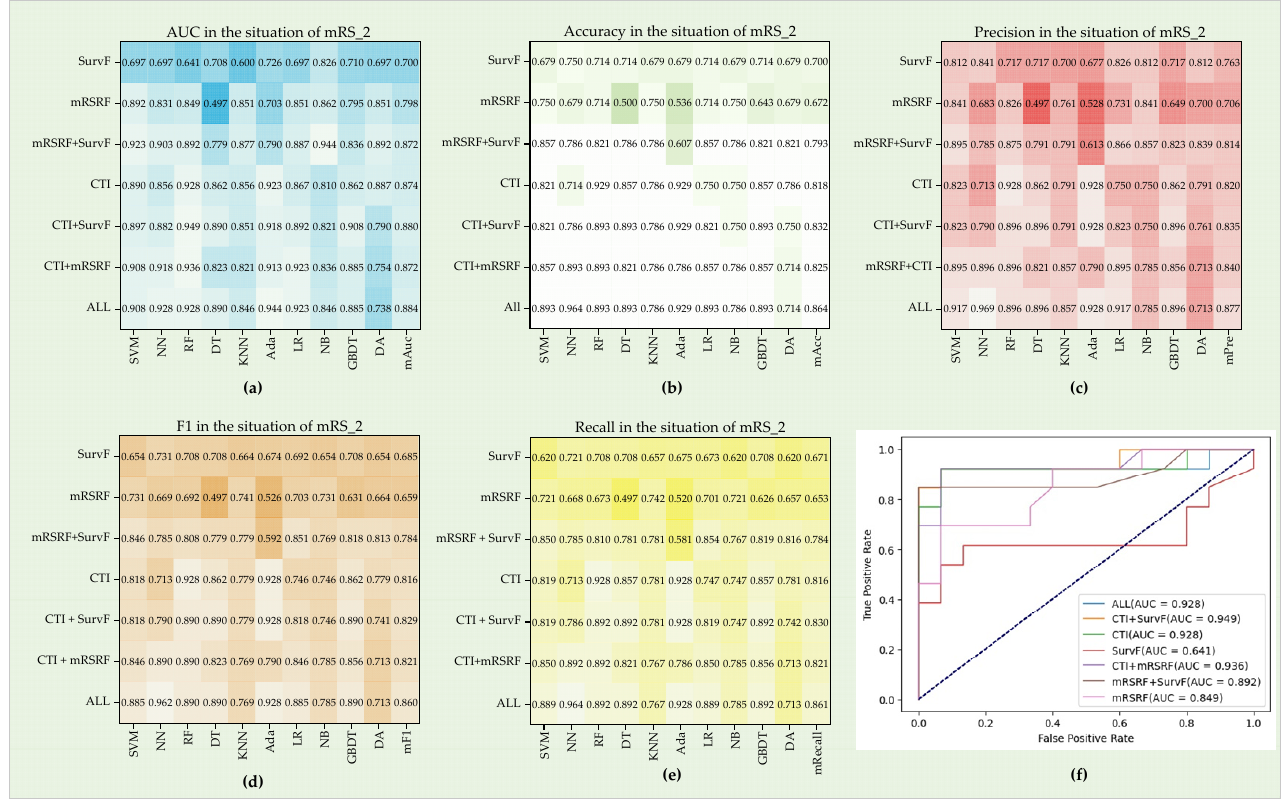
Figure 7. Performance of seven feature groups in the situation of mRS_2. ( a – e ) Auc, Pre, Acc, F1, and Recall on the ten models. ( f ) ROC curves of seven feature groups on the RF model. For mRS_4 (seen in Figure 8), the best Auc, Pre, Acc, F1, and Recall are 0.908, 0.858, 0.821, 0.802 and 0.815, respectively. ALL achieves the best mAuc of 0.787, while CTI + SurvF performs best with mAcc = 0.611, mPre = 0.622, mF1 = 0.595, and mRecall = 0.611. The results that SurvF will improve the outcome prediction and clinical performance better than mRSRF are similar to their performance in mRs_2. Moreover, the combination of CTI + mRSRF performs better than CTI in models LR, NB, and DA. For mRS_7 (seen in Figure 9), the best Auc, Pre, Acc, F1, and Recall are 0.902, 0.821, 0.75, 0.739, and 0.739, respectively. From the mean of the five indexes, CTI + SurvF performs best with mAuc of 0.788, mPre of 0.519, mAcc of 0.529, mF1 of 0.495, and mRecall of 0.47, followed by CTI, ALL, CTI + mRSRF, SurvF, mRSRF + SurvF, and mRSRF. For a single-index Auc, the best score of mRSRF is 0.644, while mRSRF + SurvF is 0.668. Similarly, CTI achieves a score of 0.891, while CTI + SurvF achieves a better score of 0.902. CTI + mRSRF achieves an Auc score of 0.843, and All achieves 0.889. The seven groups show similar performance patterns in the other four indexes such that the additional SurvF will improve the outcome prediction. In this experiment group, CTI performs better than CTI + mRSRF in all the ten